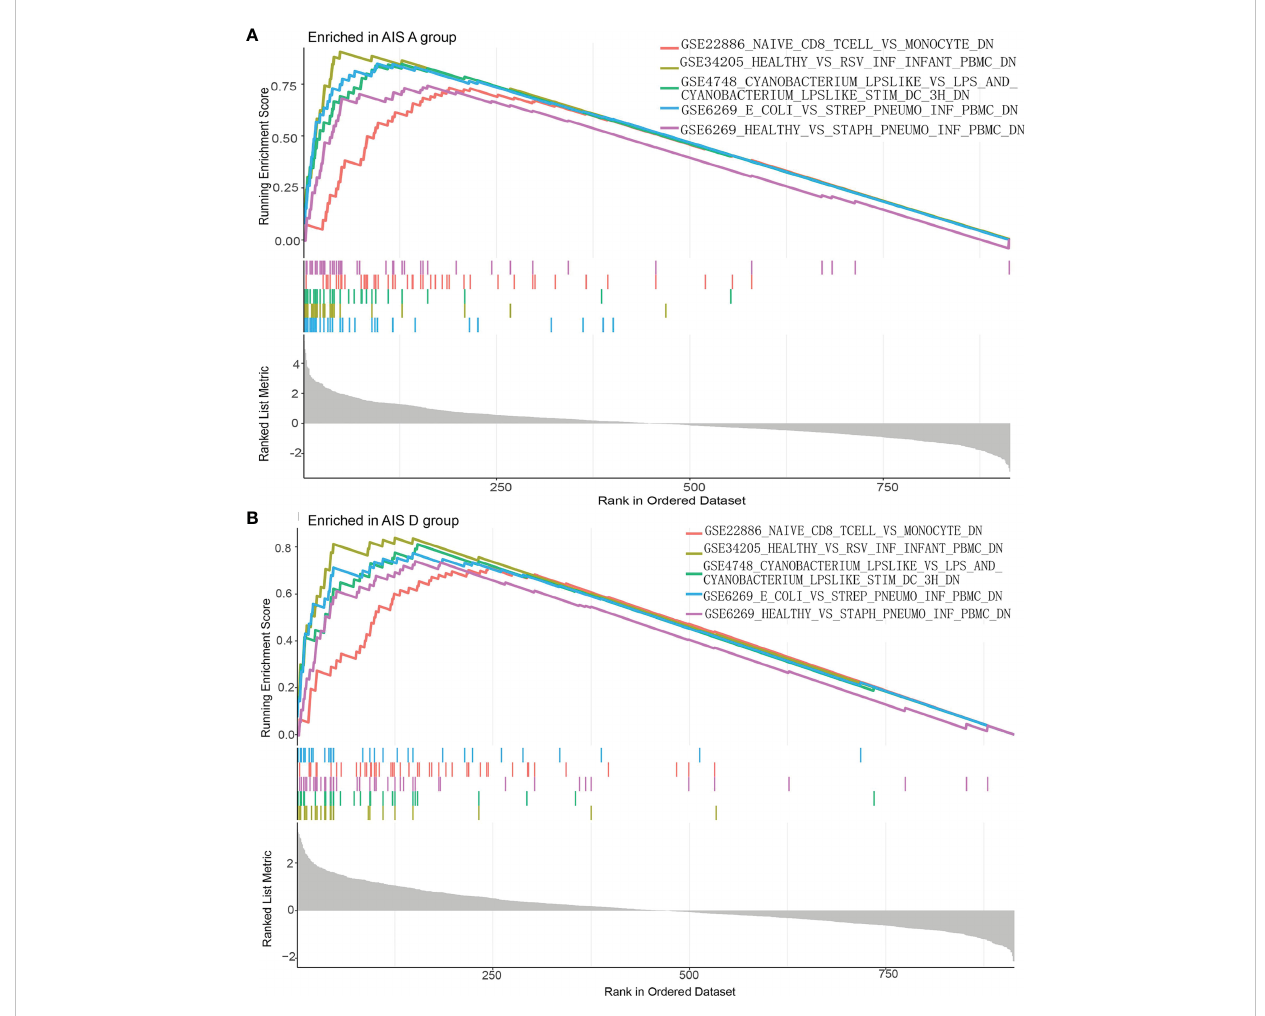
FIGURE 11 Enrichment map of the GSEA Immunologic Signature Database. (A) Enrichment map of the GSEA Immunologic Signature Database of the AIS A grade of the SCI group. (B) Enrichment map of the GSEA Immunologic Signature Database of the AIS D grade of the SCI group. SCI, spinal cord injury; HC, healthy uninjured control. GSEA, gene set enrichment